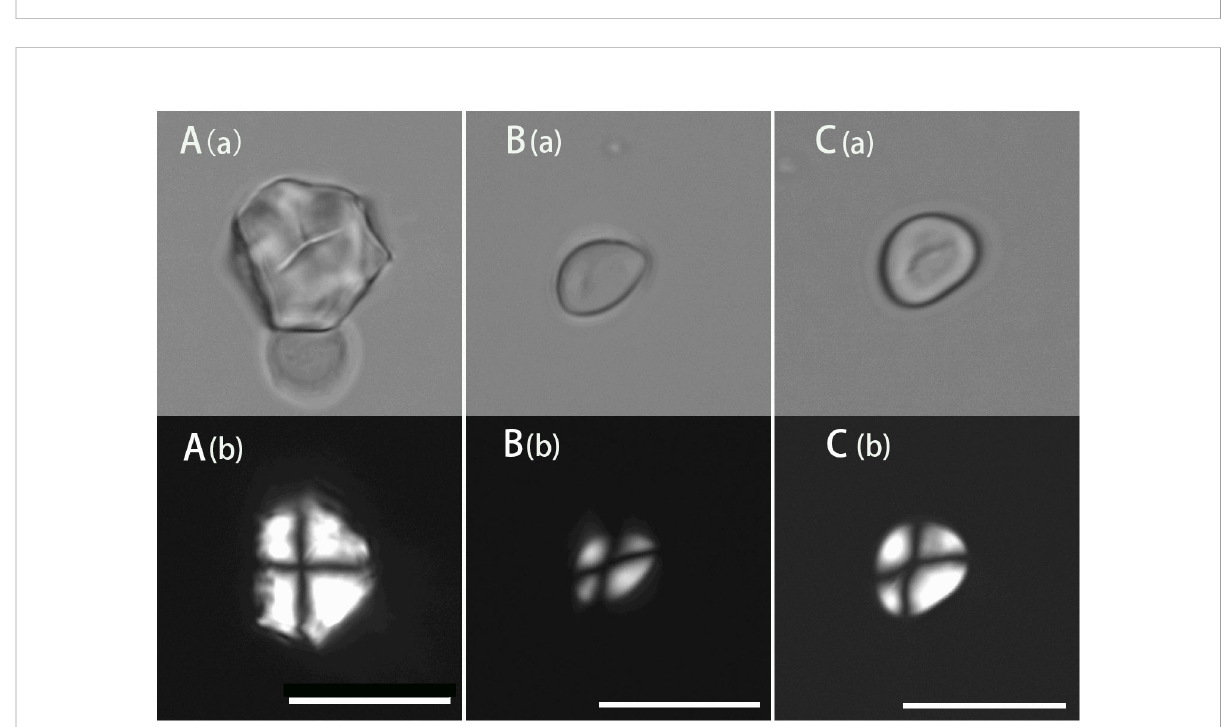
FIGURE 6 Morphological graphs of starch granules found in the Xiaodong site. Scale bar, 20 m m (a, bright fi eld light; b, cross-polarized light). (A) , ancient starch consistent with Lithocarpus mairei; (B) , ancient starch consistent with Quercus serrata; (C) , ancient starch consistent with Quercus variabilis and Quercus